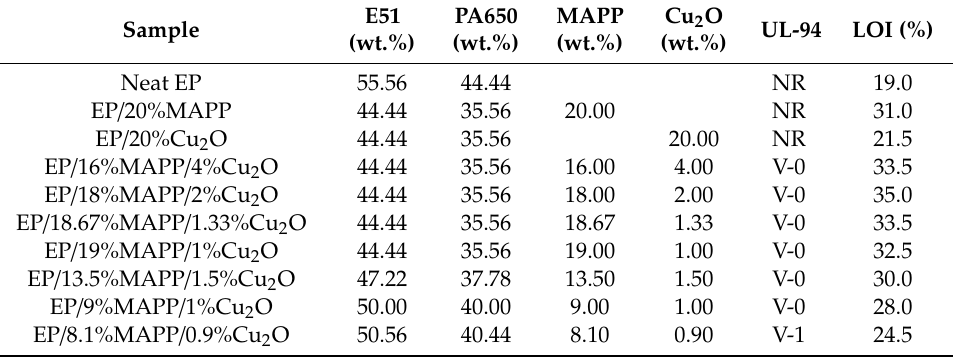
Figure 1. Synthesis route of polyethyleneimine (PEI-APP). Readapted with permission from Ref. [56], Copyright 2016, Elsevier Ltd. Table 1. Limit oxygen index (LOI) and UL-94 data of epoxy thermosets at di ff erent formulation ratios. Readapted with permission from Ref. [59], Copyright 2015, American Chemical